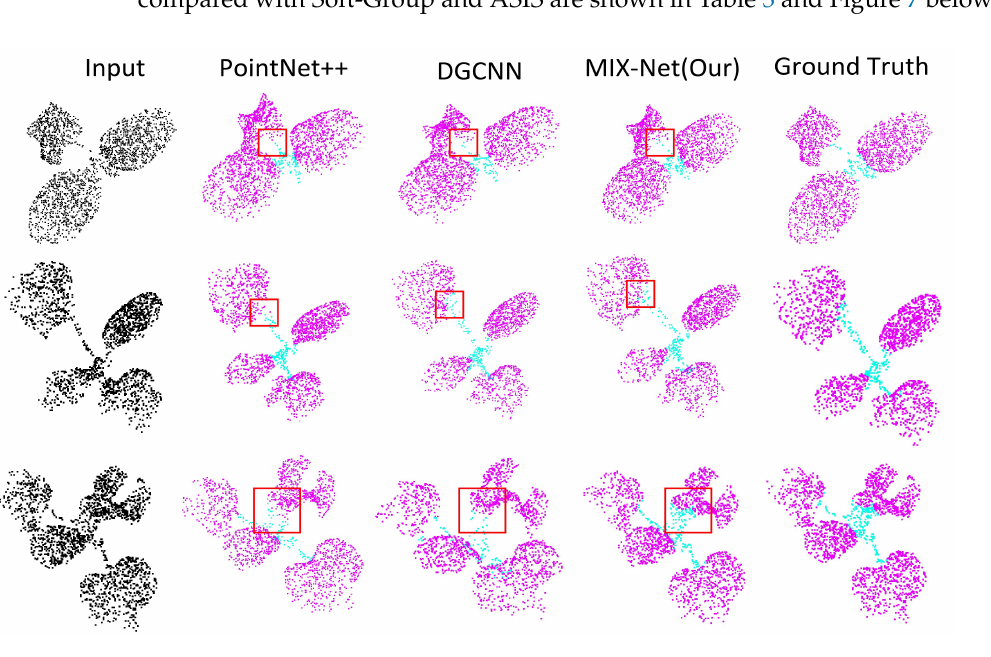
Figure 6. The qualitative semantic segmentation comparison on the three species. DGCNN and PointNet++ are compared with our MIX-Net. The parts with segmentation errors are highlighted by red dotted circles.